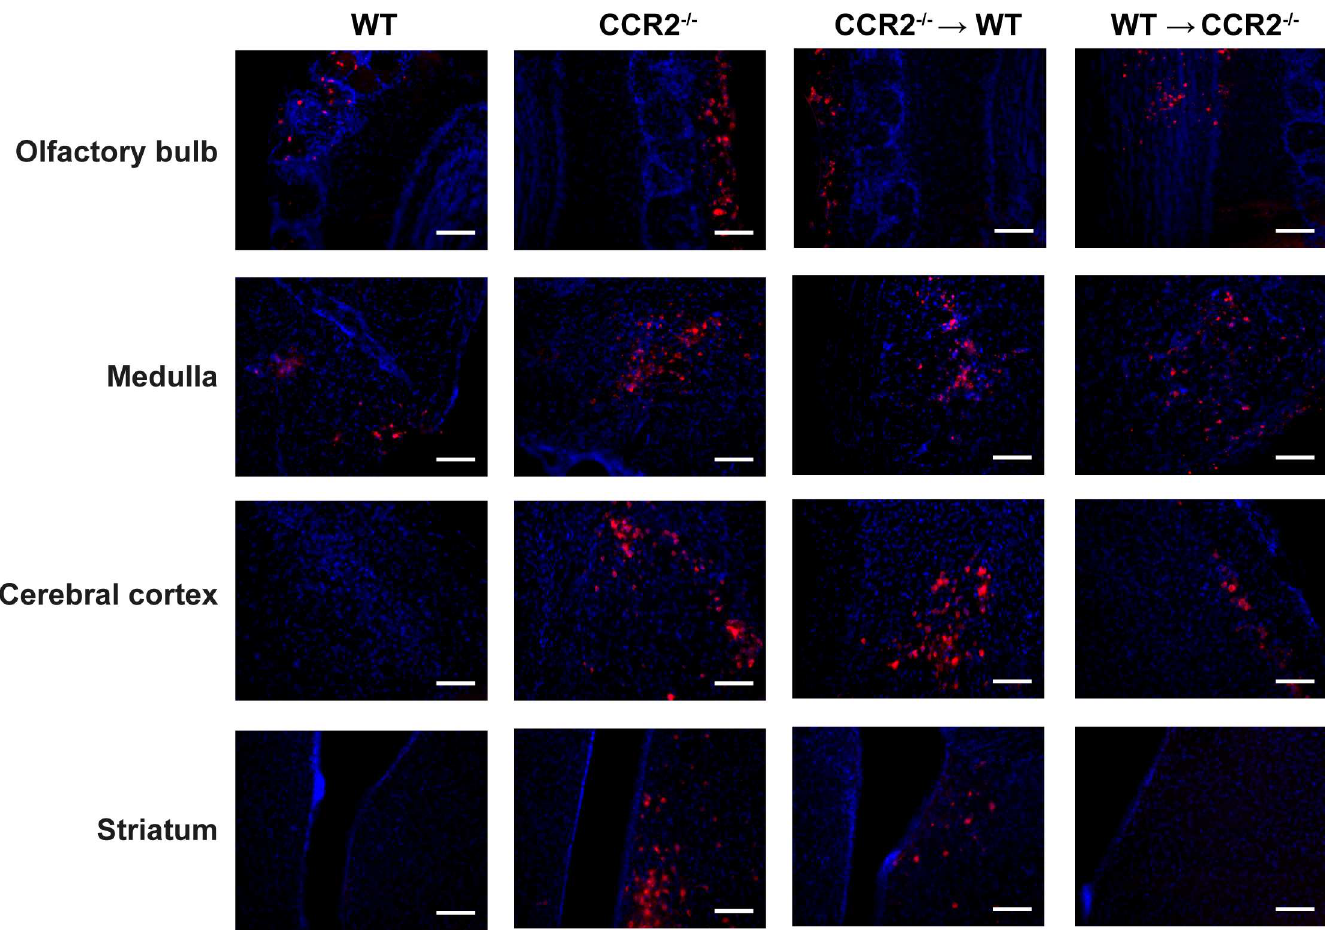
Fig 3. Impact of CCR2 deficiency in resident cells of the CNS or in the hematopoietic systemon HSV-1 distribution in the brain during HSE. Representative micrographsillustratingthe distribution pattern of HSV-1 proteins in the olfactory bulb, the medulla, the cerebralcortex and the striatum of wild-type(WT) C57BL/6, CCR2 -/- ! WT, WT ! CCR2 -/- and CCR2 -/- animals(4 to 5 mice per group) sacrificedon day 6 post-infection. Brain slices (25 μ m thick) were processedfor immunohistochemistry analyseswith a polyclonal rabbit anti-HSV-1/2primary antibodyand an Alexa 594-conjugated chicken anti-rabbitsecondary antibody (red), followedby nuclear staining with DAPI (blue). Scale bar 100 μ m.